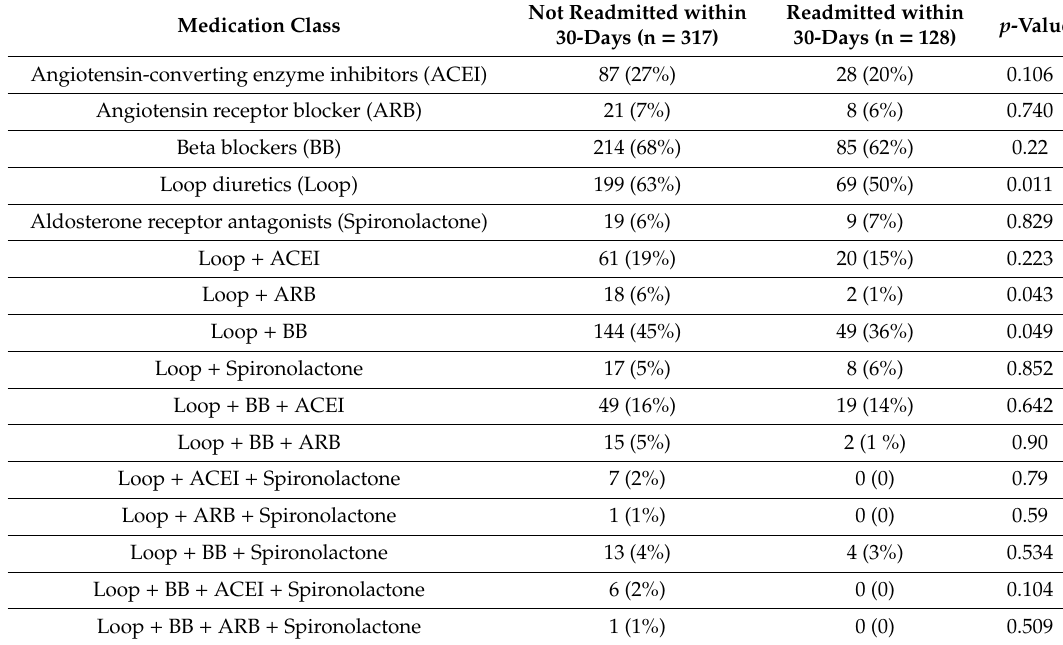
Table 2. Individual discharge medication class and combination of various medication classes by readmission status in the two-study group of